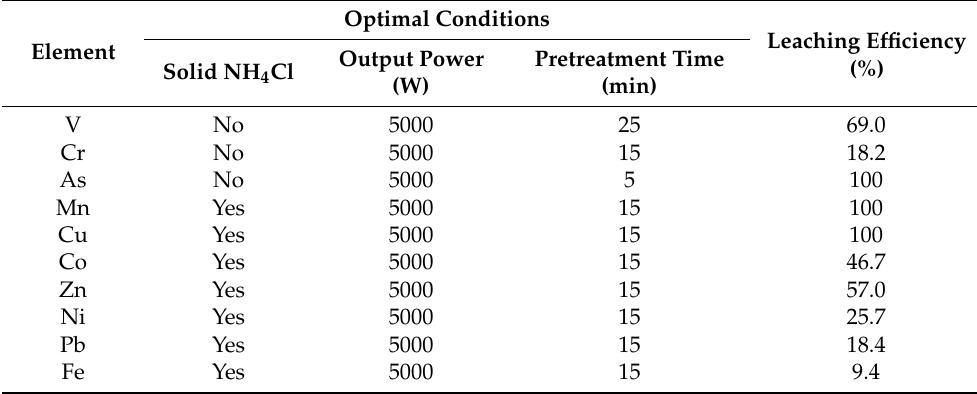
Table 3. Optimal conditions for the maximum element recovery from the red